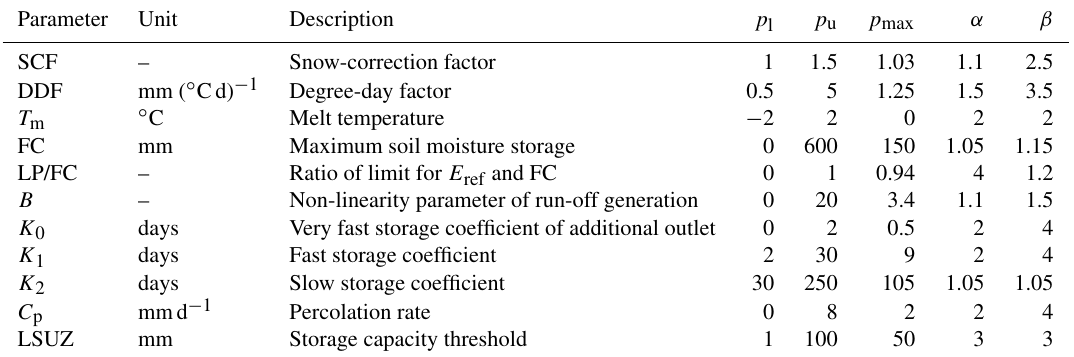
Table 1. A priori distribution of parameter values, where p l and p u are the lower and upper bounds, α and β are the parameters of the a priori distribution, and p max is the parameter value at which the a priori distribution is at its maximum. Note that the parameters T R , T S , C r and B max were set as constant and are therefore not listed